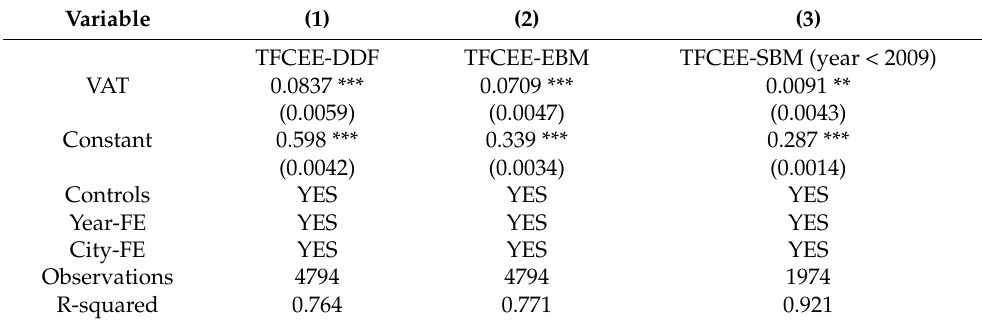
Table 5. Robustness tests: based on different measures of TFCEE and policy time